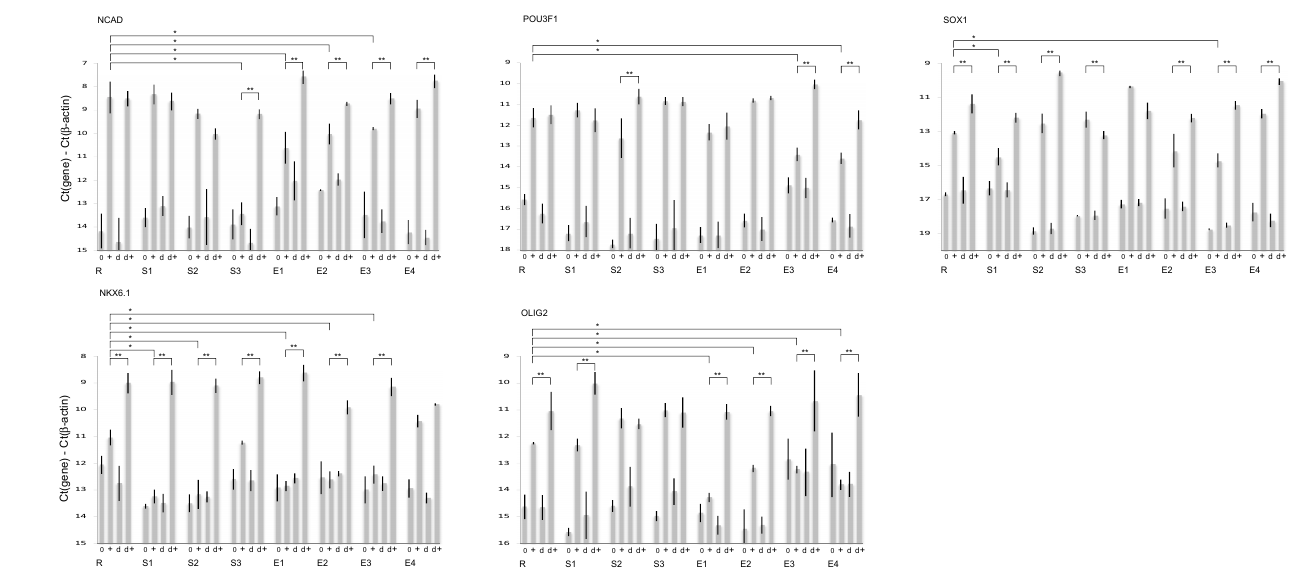
Figure 6. mRNA expression levels for the neural differentiation markers NCAD, POU3F1, SOX1, NKX6.1 and OLIG2 as measured by qPCR. Bars are grouped by which vector was used to produce each chimpanzee iPS clone: retrovirus (R), Sendai virus (S1, S2 and S3) or episomal EBNA vector (E1, E2, E3 and E4). Labels along the x axis indicate the treatment groups. Cells that have not been pretreated with 0.5% DMSO are marked 0 before differentiation and + after the differentiation protocol. Cells that have been pretreated with 0.5% DMSO are marked d before differentiation and d + after the differentiation protocol. A single asterisk indicates the cells in this group display significantly lower marker expression ( p < 0 . 05 one-way ANOVA followed by Dunnett’s test) than the retrovirally generated clone subjected to the differentiation protocol but not pretreated with DMSO. A double asterisk indicates that the cells in this group, when differentiated after pretreatment with DMSO, display significantly increased marker expression ( p < 0 . 05 one-way ANOVA followed by Dunnett’s test) when compared with their same clone controls that were not pretreated with DMSO. Each directed differentiation was replicated three times per clone and averaged: n =